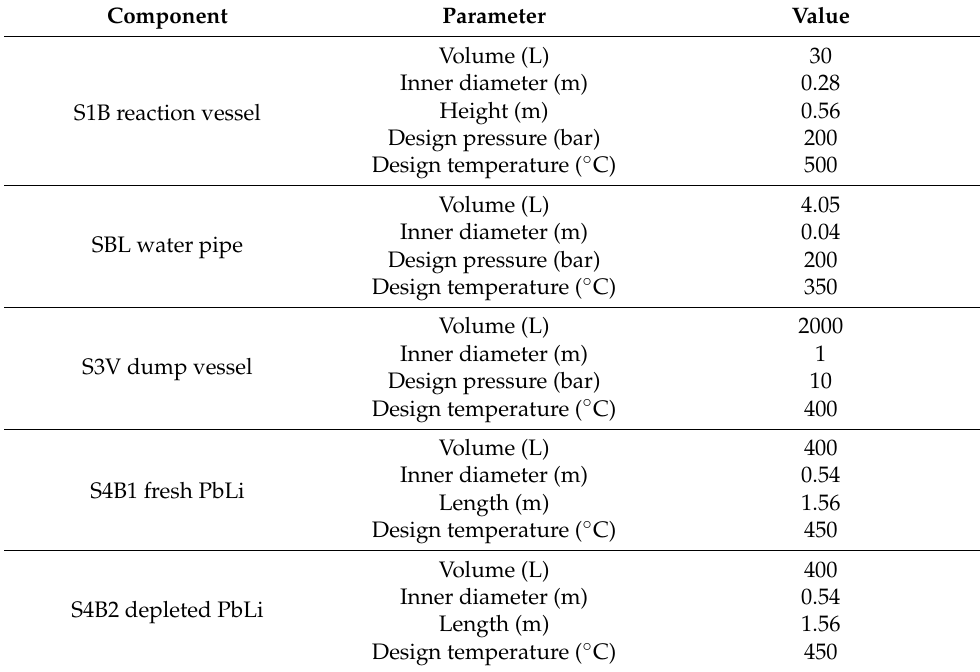
Table 1. LIFUS5/Mod3 component design